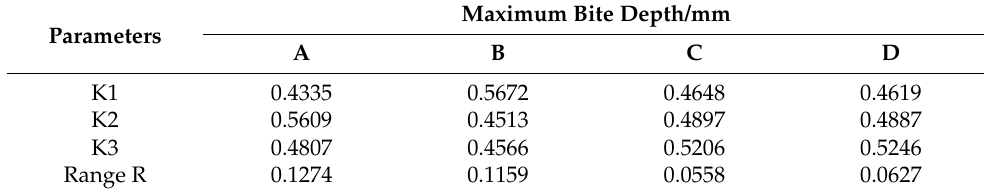
Table 6. Range analysis of maximum bite